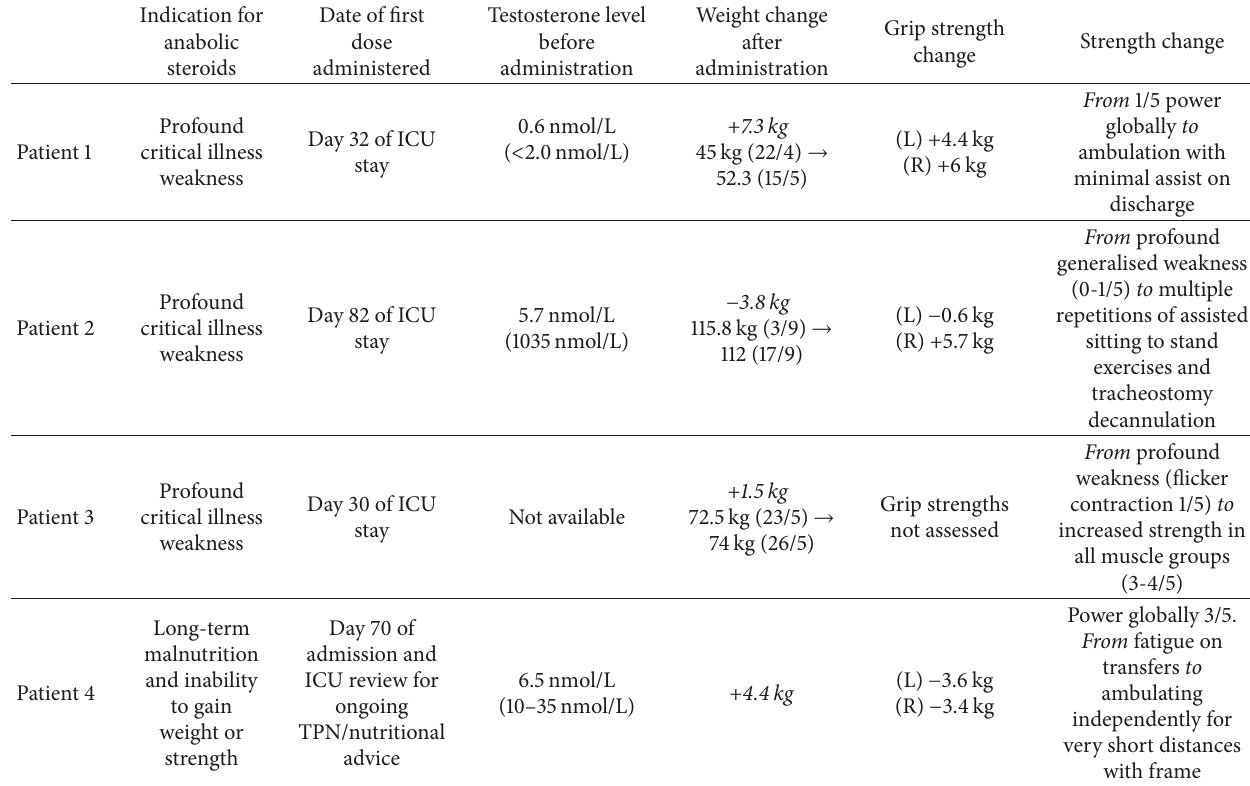
Table 1: Overview of indications and results of anabolic steroid